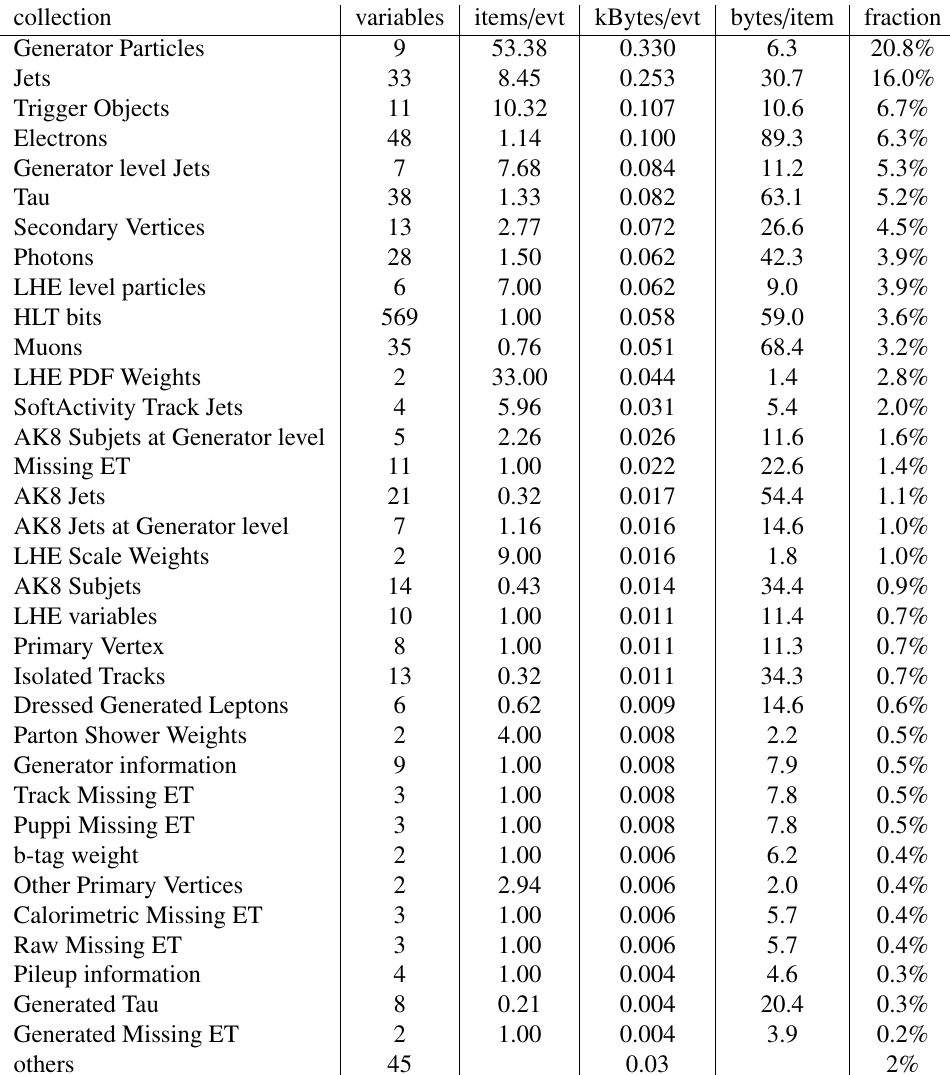
Table 1. Average space usage for each collection in NANOAOD for a simulated t ¯ t sample with Run 2 pileup scenario. The second column shows the number of variables associated to each item in the collection, the third column contains the average number of items per event (no maximum hard limit is Figure 1. NANOAOD composition in term of relative size used by each object collection, on a simu- enforced), the fourth column shows the size per event while the fifth has the size per item, the last lated t ¯ t sample. column is the fraction of NANOAOD budget used by each